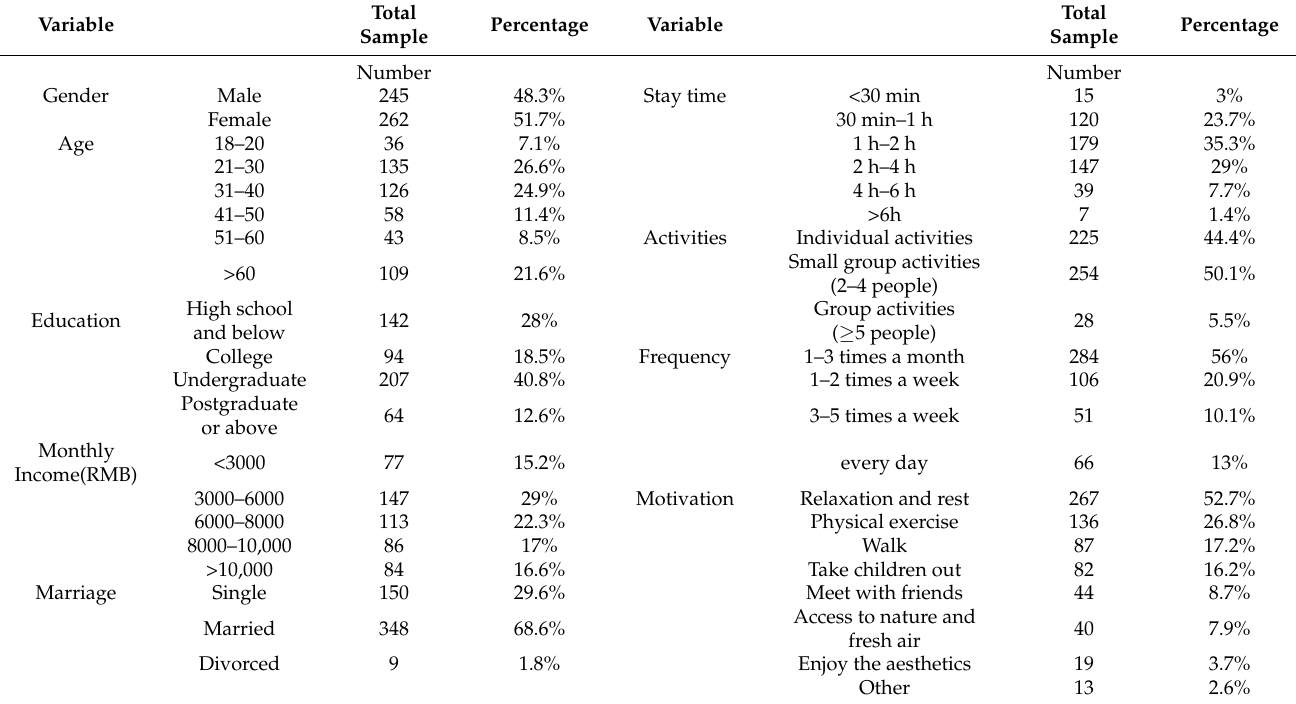
Table 4. Demographics of the visitors who participated in the